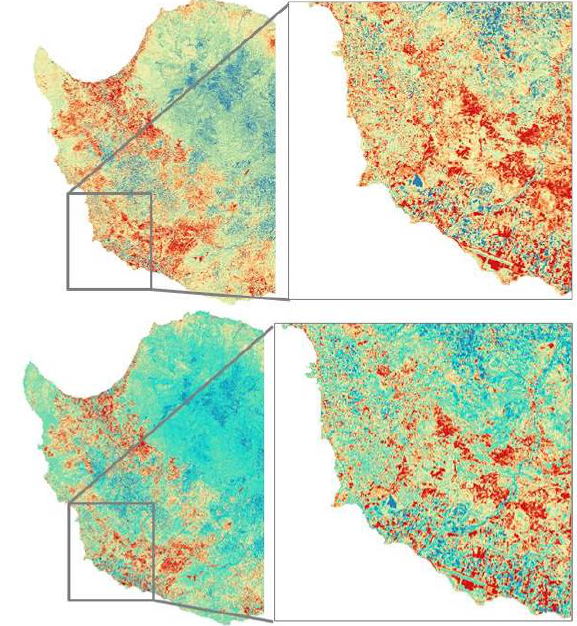
Figure 2 Differences in NDVI values in false